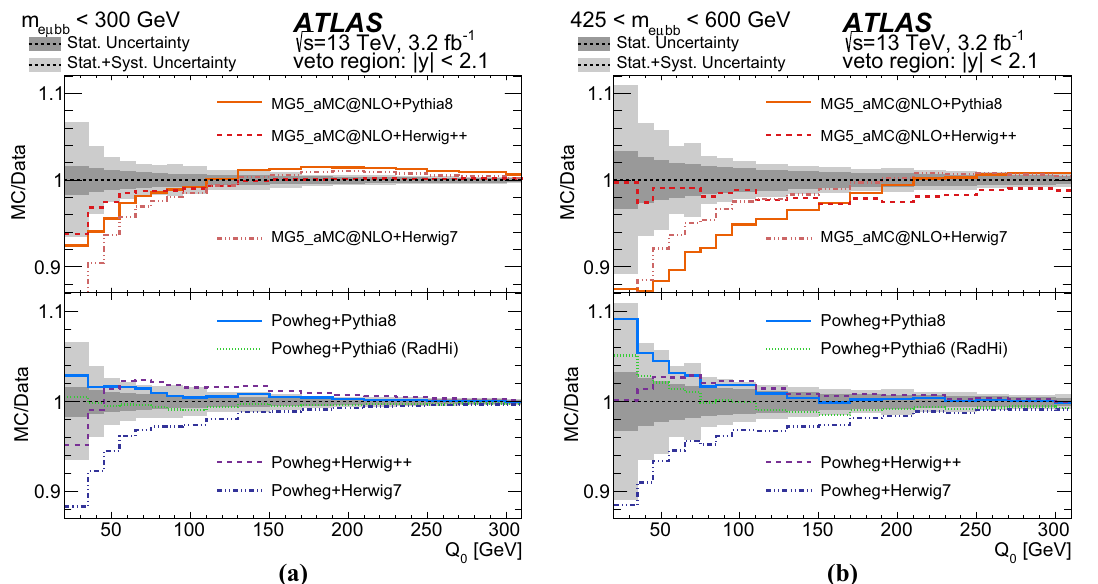
Fig. 15 Ratios of prediction to data of the measured gap frac- indicated by the shaded band , and the Q 0 thresholds corresponding to the left edges of the histogram bins , except for the first bin tion f part gap ( Q 0 ) as a function of Q 0 in the full central veto region | y | < 2 . 1 for the invariant mass regions a m < 300 GeV and b e μ bb 425 GeV < m e μ bb < 600 GeV. The predictions from various t ¯ t sim- ulation samples are shown as ratios to data, with the data uncertainty